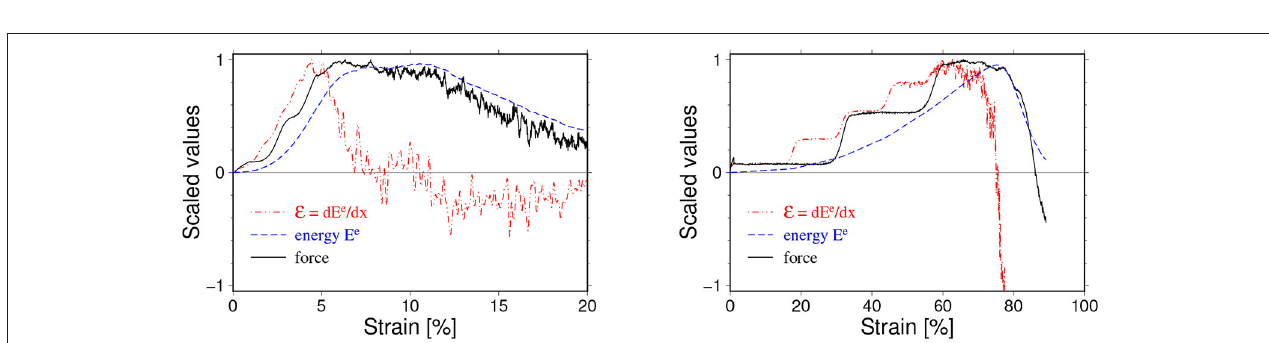
FIGURE 12 | Snapshots of the microscopic state of a sample undergoing a hyper-elastic breaking process at selected (indicated above panels) strains. Short colored segments represent inter-particles bonds existing at given loading stage and their extension with respect to initial values are mapped by colors. The corresponding loading curves are shown in Figure 9 . A release of an internal elastic stress by developing fracture system is clearly visible. The particle-particle interaction parameters for this case read: k n = 10 5 N/mm, b d = 0.4 mm.